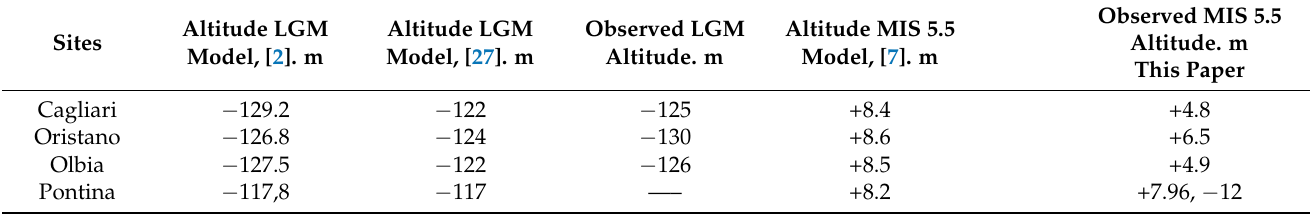
Table 2. Modelled and observed altitude during LGM (21.5 kyrs cal BP) and MIS 5.5 (119 Kyrs BP). Altitude LGM Altitude LGM Observed LGM Altitude MIS 5.5 Sites Model, [2]. m Model, [27]. m Altitude. m Model, [7]. m